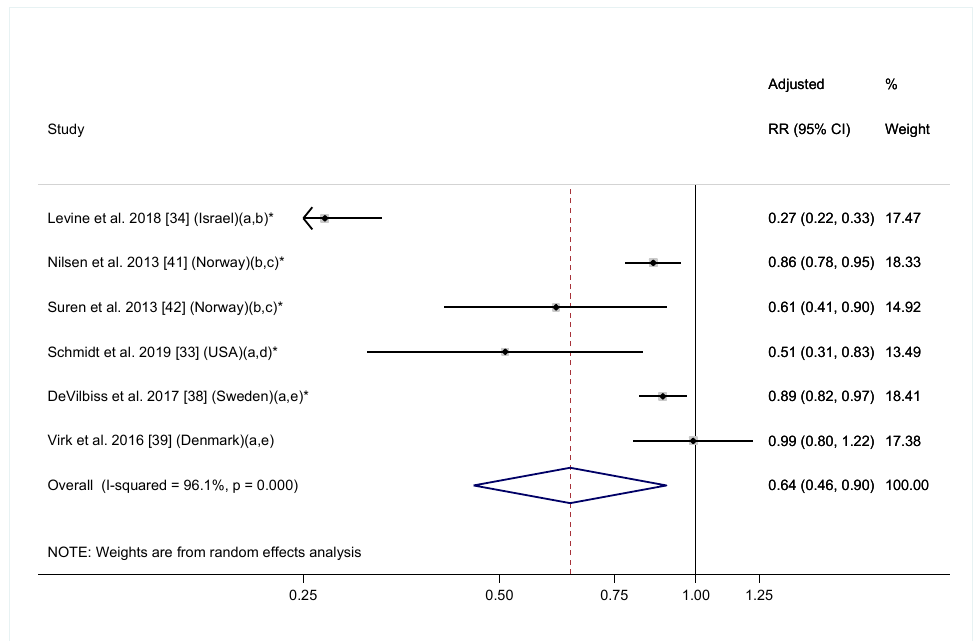
Figure 3. Adjusted odds ratios (ORs) of offspring ASD risk associated with maternal intake of supplement containing folic acid, multivitamin or prenatal vitamin during pregnancy (with or without pre-pregnancy use). The overall effect size was estimated using random effects models weighted by inverse variance of each study. One data point was included for each study. Estimates covering any period during pregnancy were included. When estimates for folic acid and multivitamin were both available, the one for folic acid were selected. Notes: (a) Exposure during pregnancy; (b) Intake of supplement containing folic acid vs. no; (c) Exposure before and during pregnancy; (d) Folic acid intake ≥ 600 mcg/day vs. <600 mcg/day; (e) Intake of multivitamin vs. never/rarely. * p < 0.05.